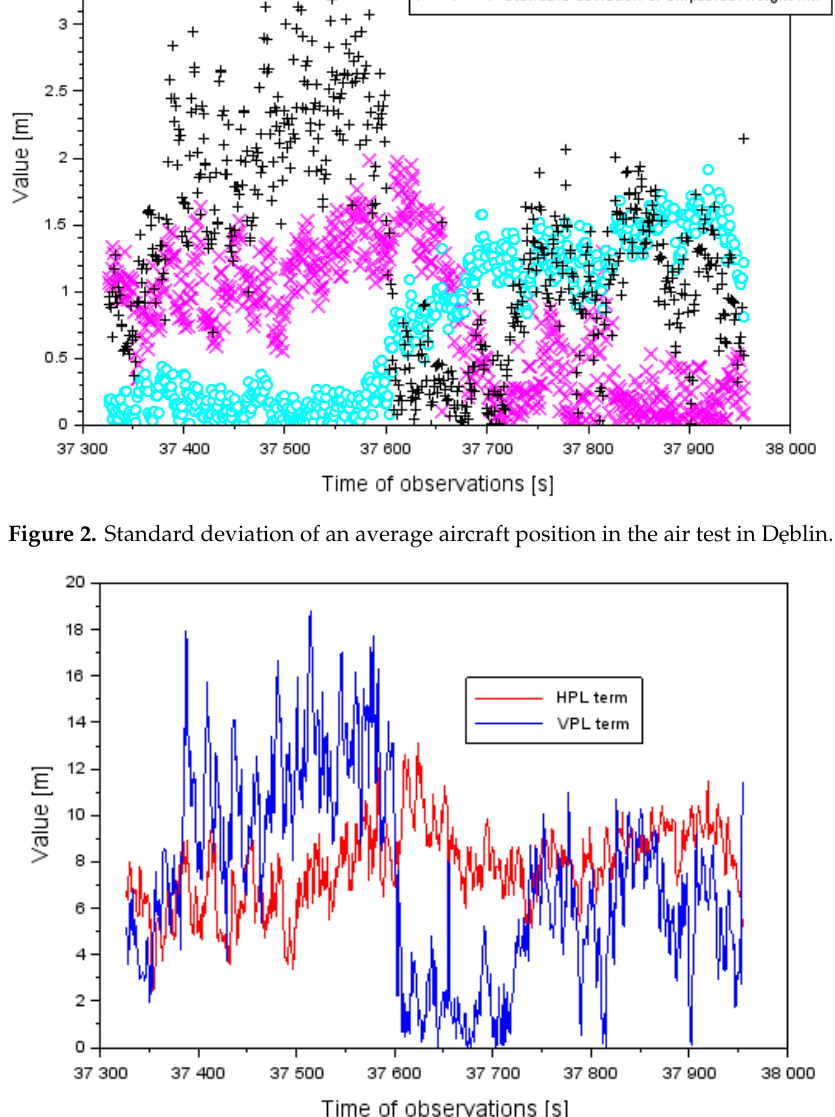
Table 2. The values of the availability and continuity terms in the air test in D ę blin. Parameter